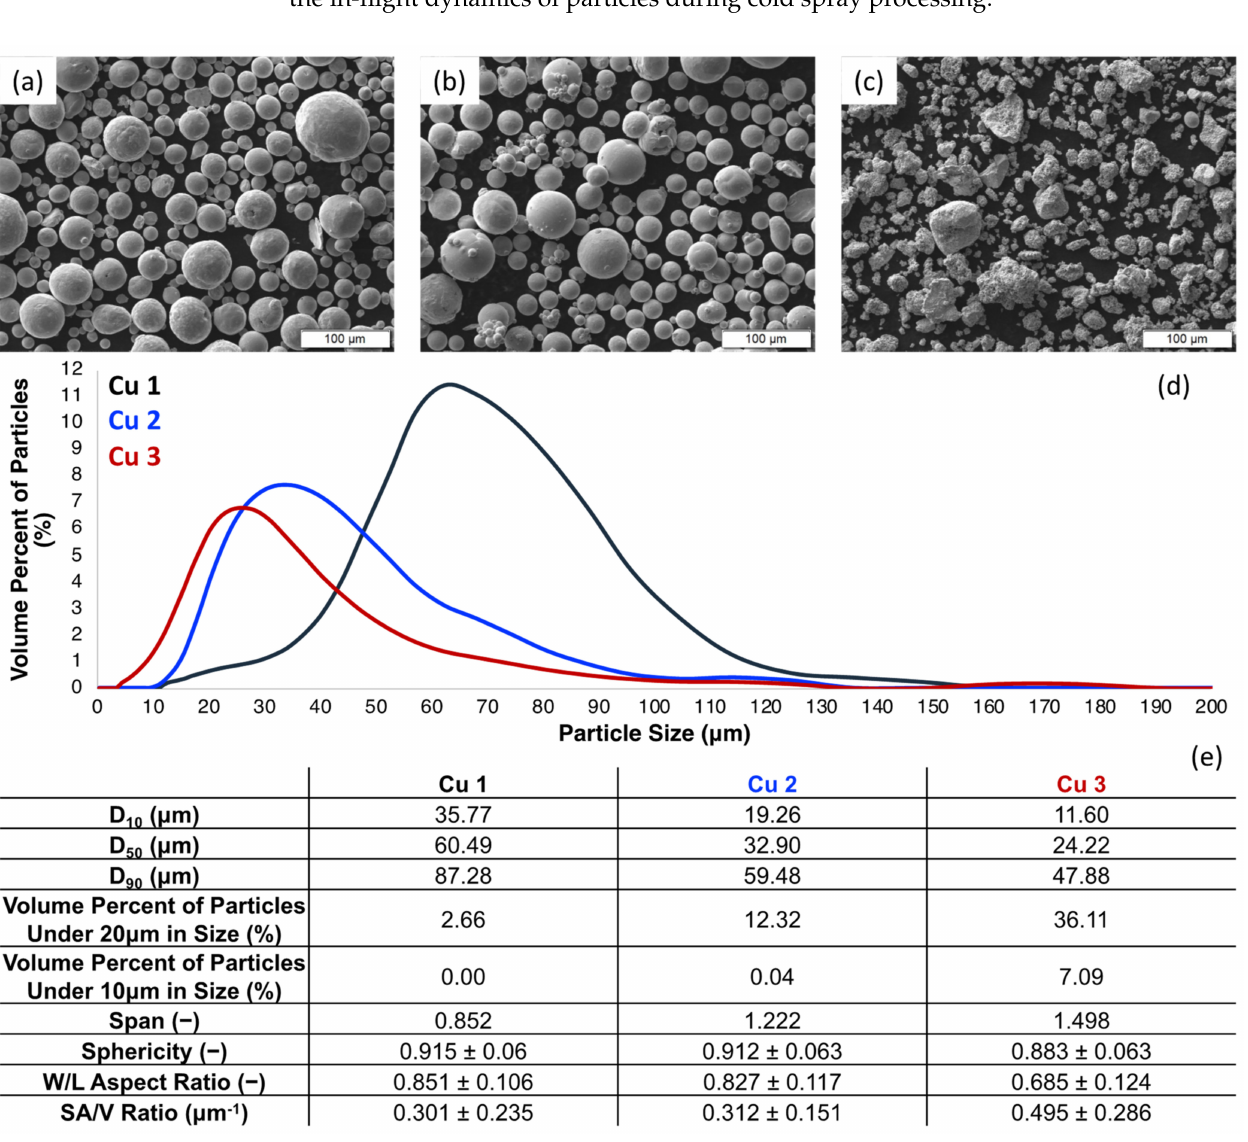
Figure 1. ( a – c ) SEM micrographs, ( d ) particle size distributions, ( e ) tabulated particle size and shape data for Cu